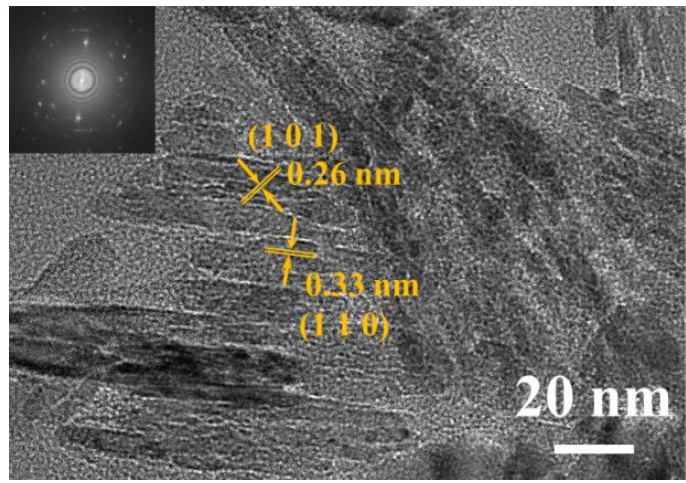
Figure 2. High-resolution HRTEM images of SnO 2 nanoflowers. The inset shows the corresponding selected area electron diffraction (SAED) image.